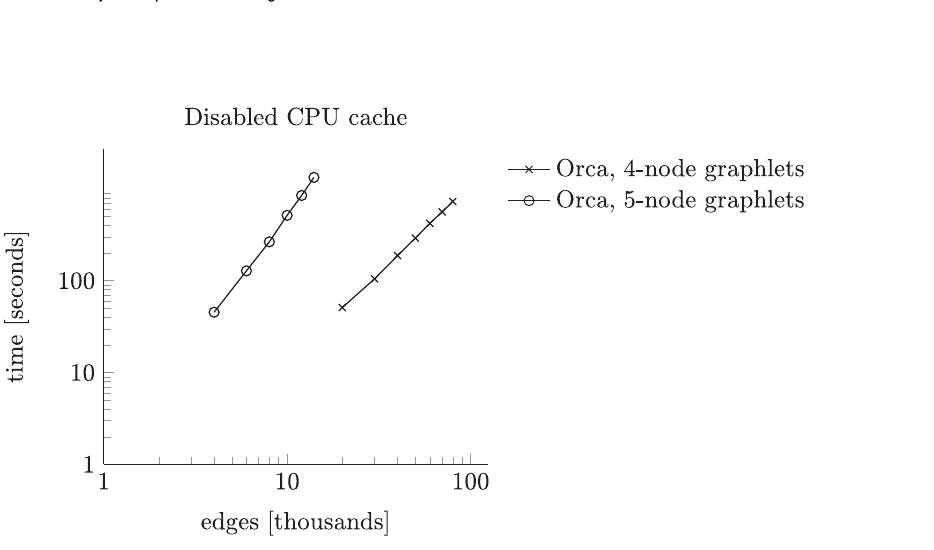
Fig 9. Polynomial time complexity. Comparisonof countingtimes for orbits of 4- and 5-nodegraphletson sparse graphs with 10000 nodesand varying densities.